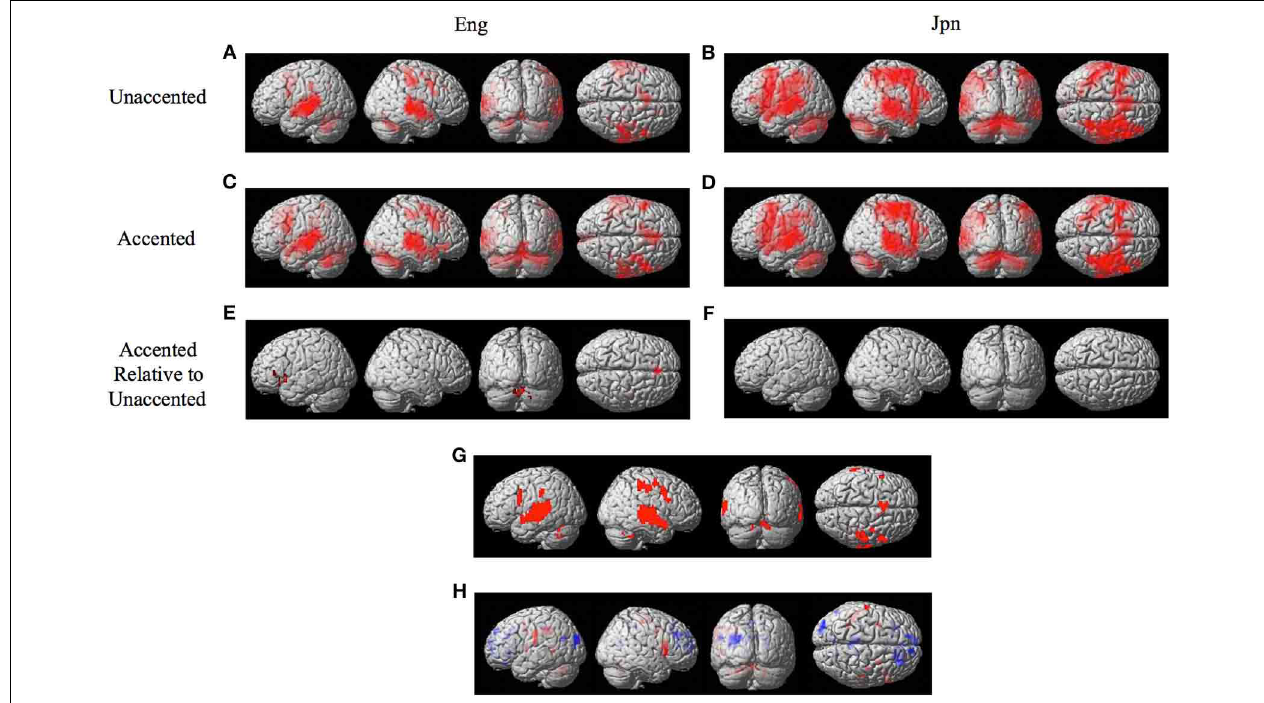
FIGURE 2 | Significant brain activity (thresholded at pFDR < 0.05 corrected) for the contrast of (A) Eng (unaccented), (B) Jpn (unaccented), (C) Eng (accented), and (D) Jpn (accented). All contrasts showed activity bilaterally in premotor cortex and Broca’s area, the superior temporal gyrus/sulcus, the inferior parietal lobule, the pre- supplementary motor area pre-SMA, and the cerebellum. The conjunction analysis, shown in (G) , confirmed these regions were active for all conditions (E) . The contrast of accented Relative to unaccented